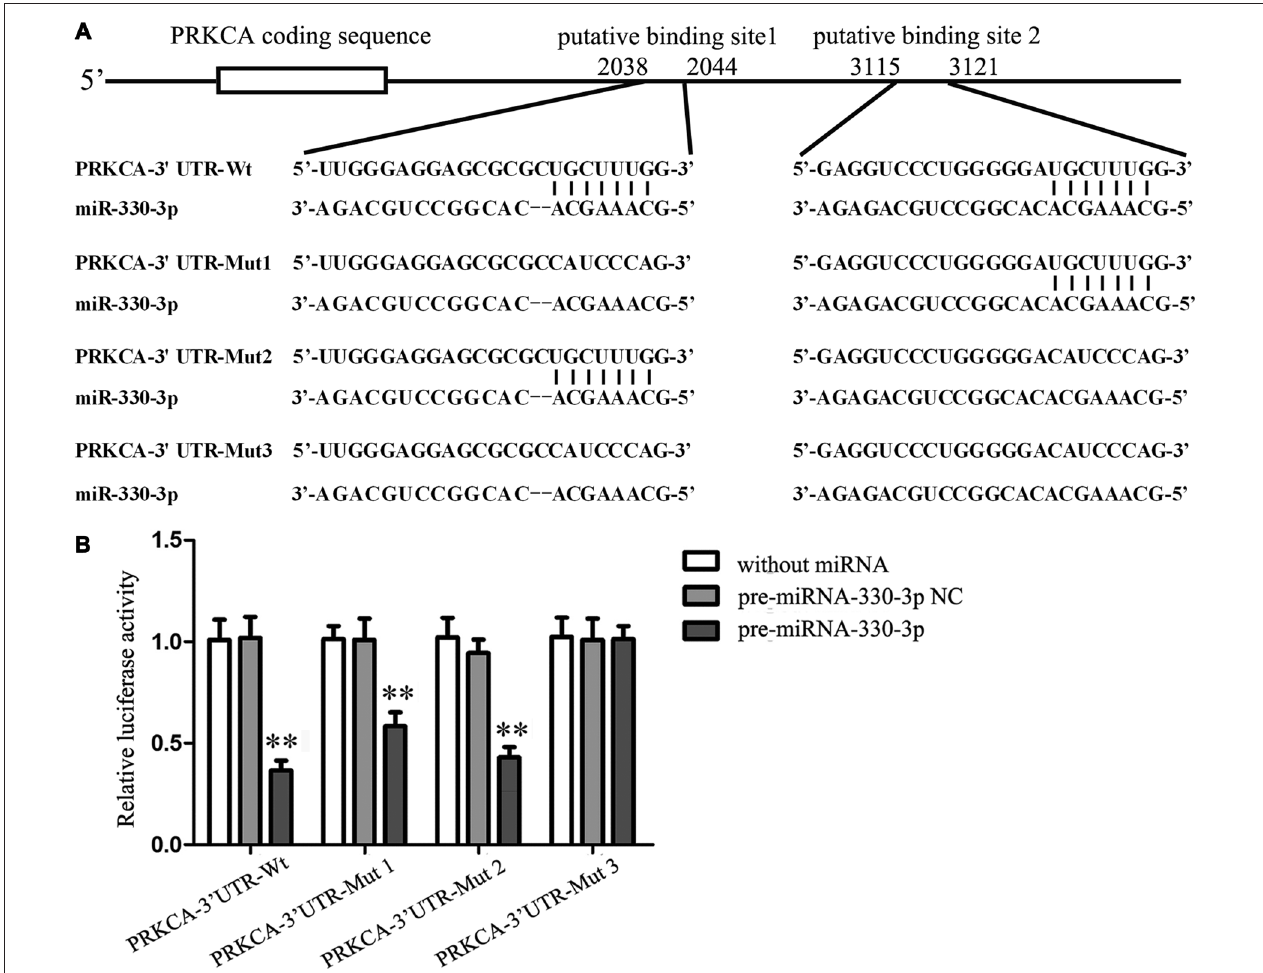
FIGURE 3 | PKC α was a target gene of miR-330-3p. (A) The putative binding sites of PKC α 3 (cid:48) UTR (PRKCA-3 (cid:48) UTR) matching with the seed region of miR-330-3p were predicted with the help of TargetScan and the site mutagenesis design for the reporter assay (PRKCA-3 (cid:48) UTR-Mut1, PRKCA-3 (cid:48) UTR-Mut2, and PRKCA-3 (cid:48) UTR-Mut3). (B) Relative luciferase activity was expressed as firefly/renilla luciferase activity. Values are means ± SD ( n = 5, each). ∗∗ P < 0.01 vs.